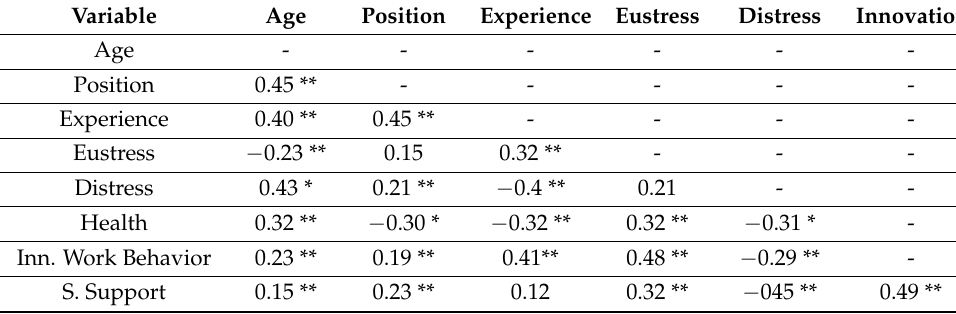
Table 3. Correlations among the studied variables.